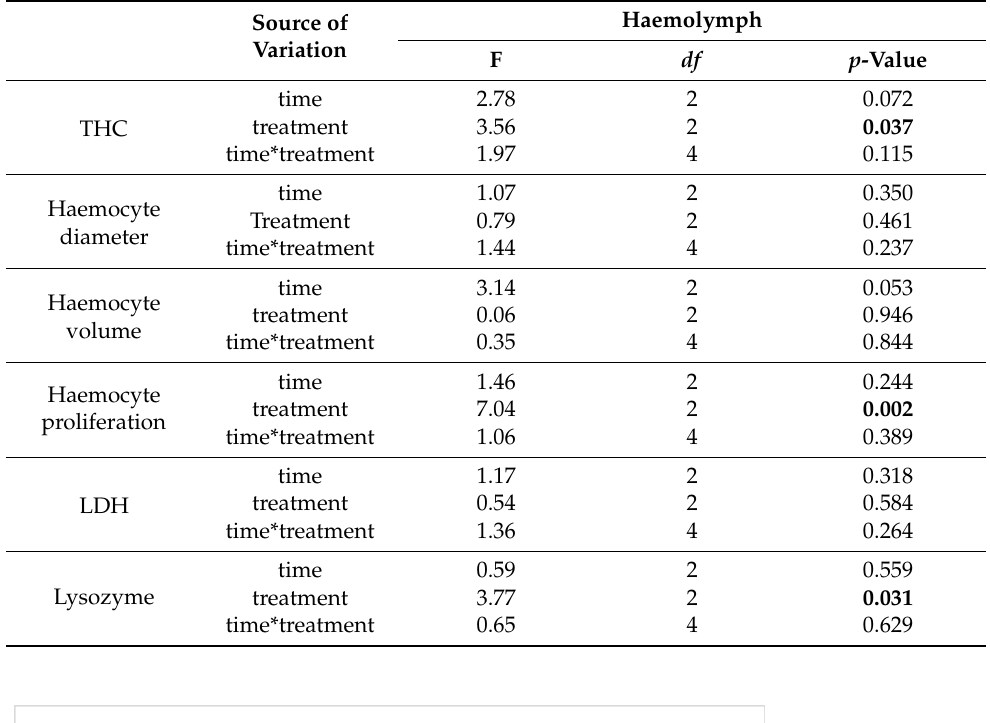
Table 2. Results of two-way ANOVA analysis for the haemocyte biomarkers measured in the haemolymph of Ruditapes philippinarum after exposure to HHCB. Statistically significant effects of the variables “time”, “treatment” and “time*treatment interaction” are indicated in bold .